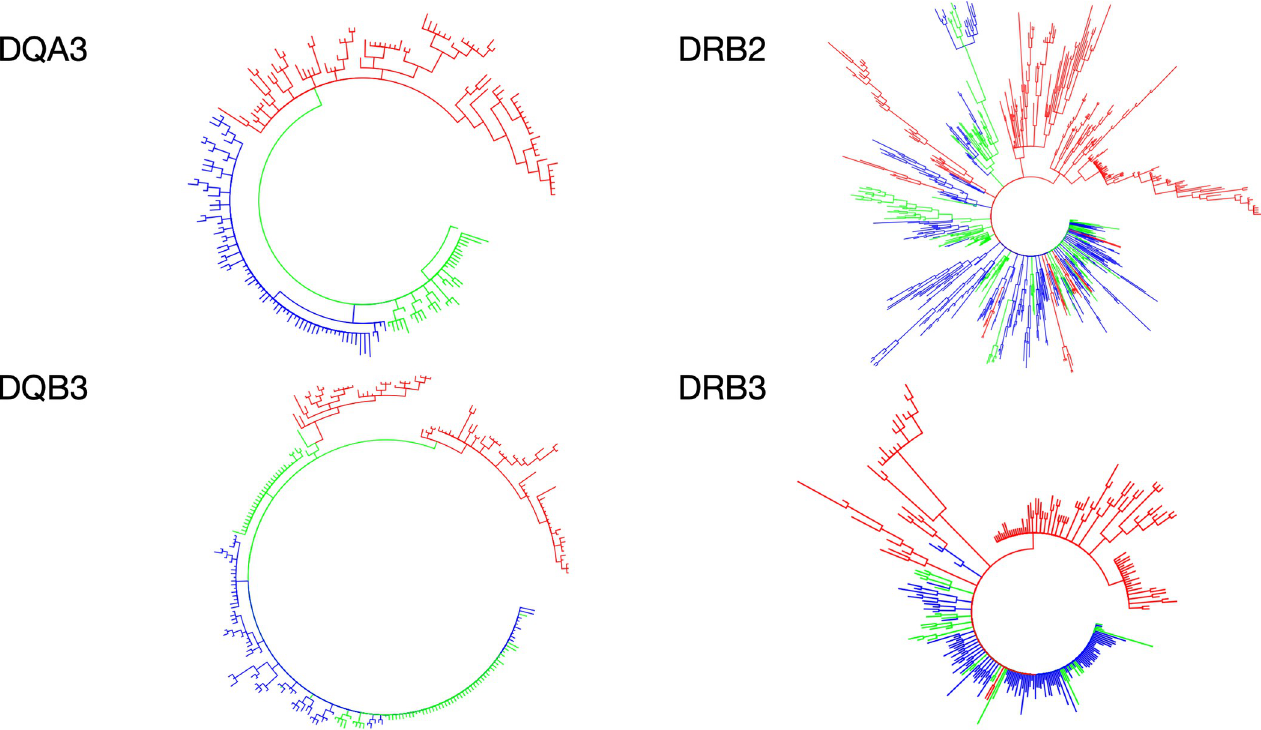
Fig 4. Polar gene trees. (A) DQA3, (B) DRB2, (C) DQB3 and (D) DRB3. Colors indicate major primate clades: Red–Platyrrhini; Blue–Cercopithecoidea; Green–Hominoidea.